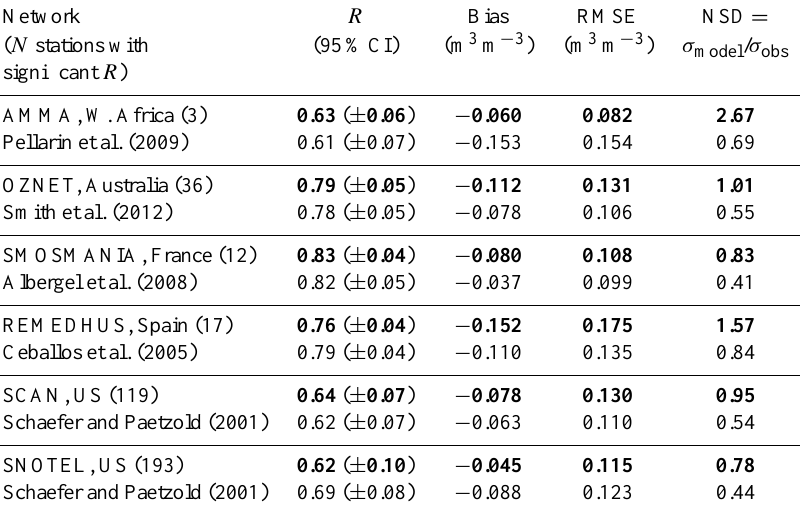
Table 2. Comparison of surface soil moisture with in situ observations for ERA-Interim/Land (bold) and ERA-Interim (normal font) in 2010: mean correlation ( R ), bias (observation minus ERA), root mean square error (RMSE), and normalized standard deviation (NSD = SD model /SD obs ) . Scores are given for significant correlations with p values < 0.05. For each R estimate a 95% confidence interval (CI) was calculated using a Fisher Z